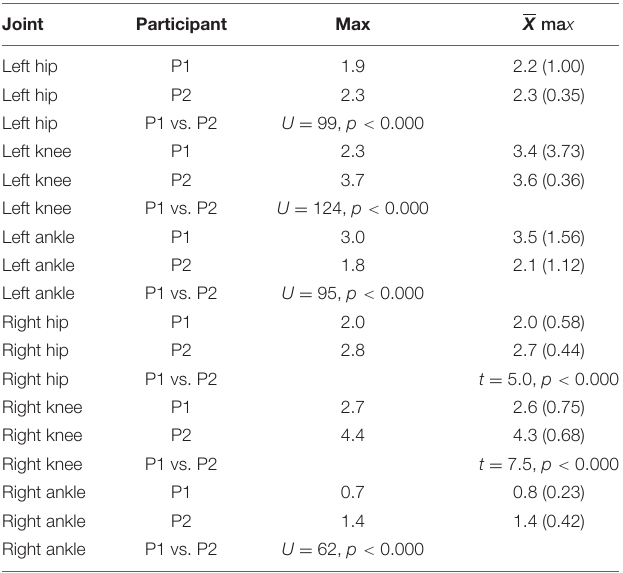
TABLE 2 | Median and mean maximum angular velocities and standard deviations in degrees per second for each joint and